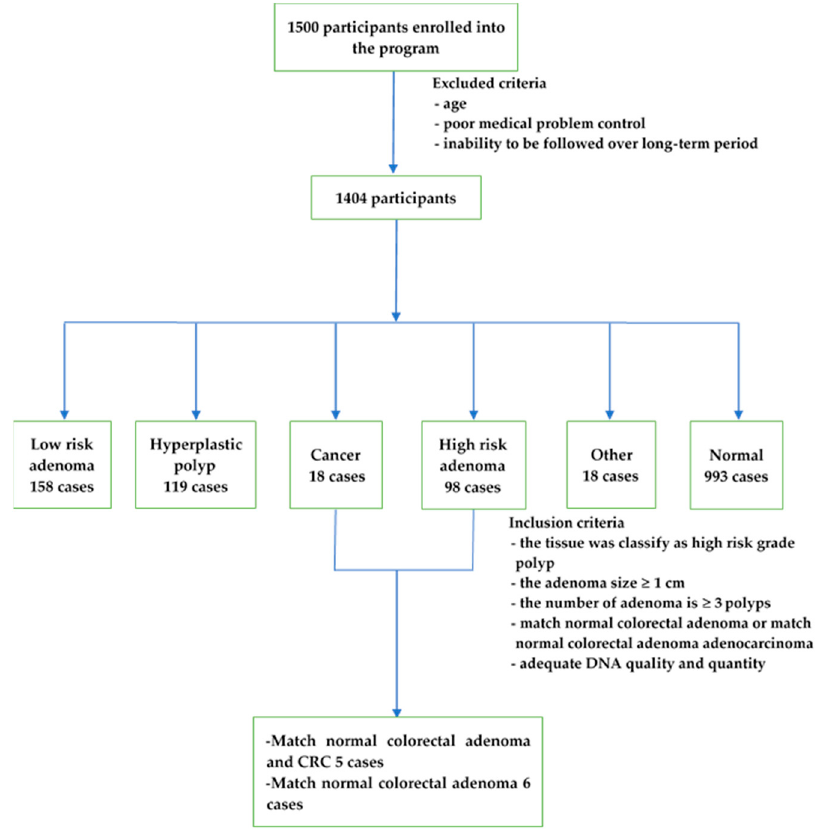
Figure 6. Data flow of participants with the inclusion and exclusion criteria (modified from [8]) .